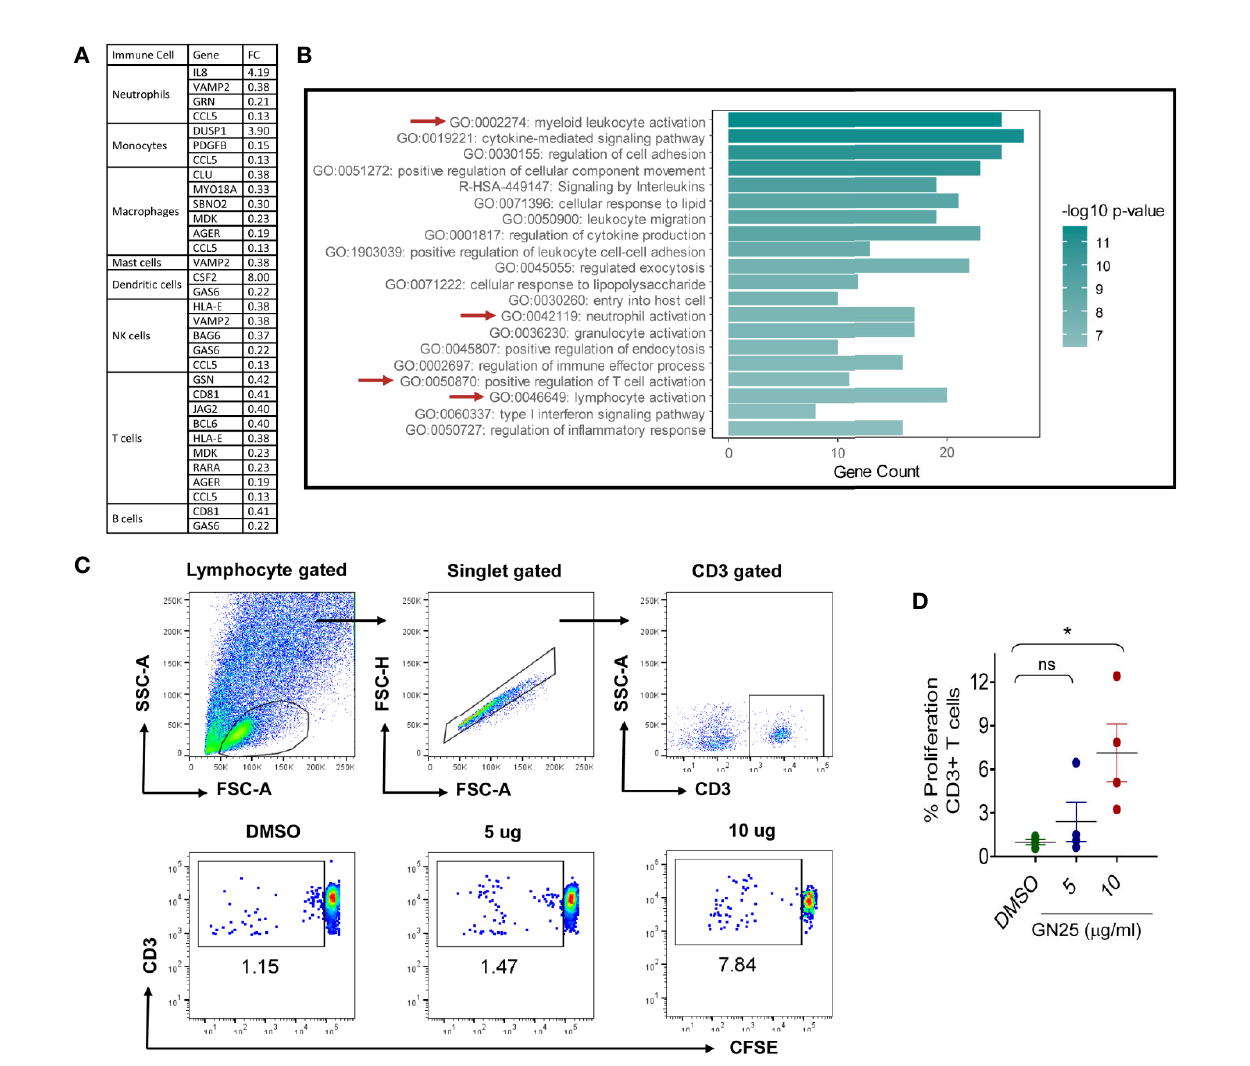
FIGURE 3 | Most signi fi cantly enriched immune pathways within the immunomodulatory signature of GN25 (A) . The differentially expressed genes (Fold changes cut-off >2 and <0.5) enriched in the gene ontology data sets for the activation and chemotaxis of each immune cell type (B) . Pathway analysis of Differentially expressed genes enriched in the Immunome and activation/chemotaxis Gene ontology sets of each immune cell type. Pathway analysis done using Metascape (C) . Representative FACS plots showing the percent of CFSE+ CD3+ cells co-culture with A549 cells treated with 5 and 10 µM GN25 as well as vehicle control (D) . dotplot representation of mean percentage ± SEM of CD3+ cells proliferation in response to co-culture with A549 cells treated with 5 and 10 µM GN25 as well as vehicle control. Data shown are from four healthy individuals. * represents p-value